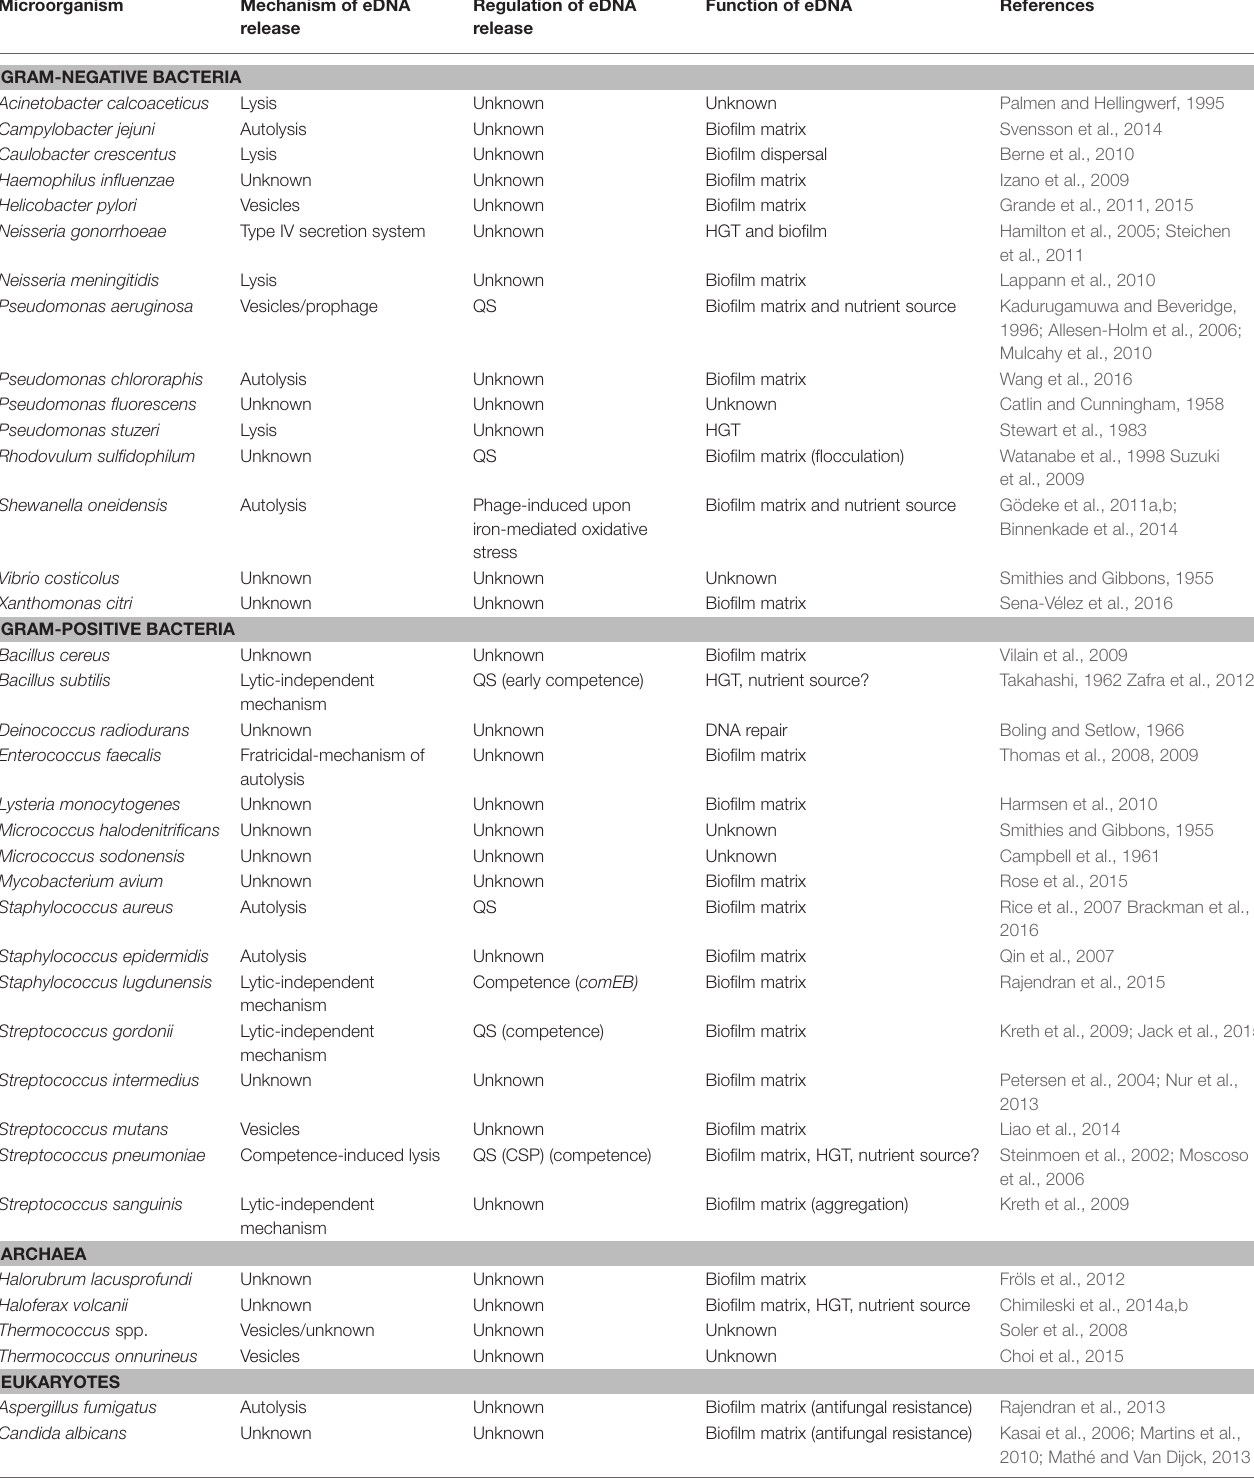
TABLE 1 | Microorganisms producing eDNA and their release